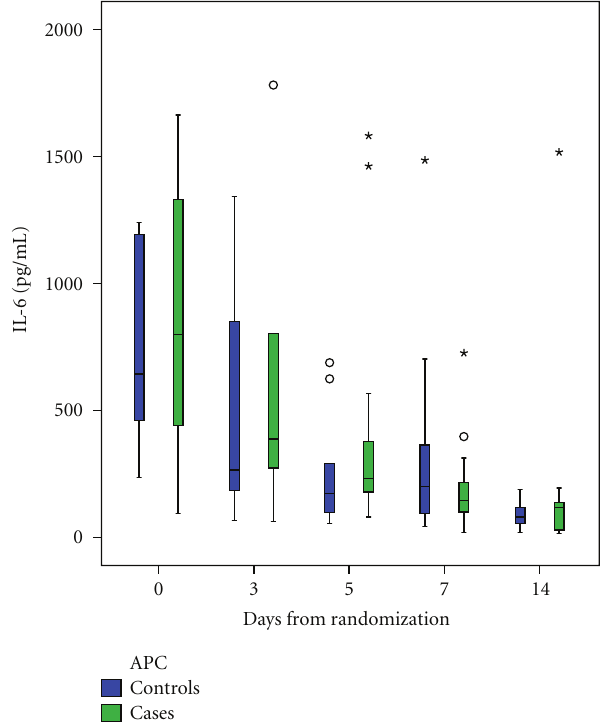
Figure 1: The changes in concentrations of IL-6 during the follow- up time. The APC did not have significant e ff ect on the changes ( P = 0 . 288). Box-Whisker plots show median, interquartile range (box) and highest and lowest values. Outliers (circles) and extreme values (asterisks) are shown